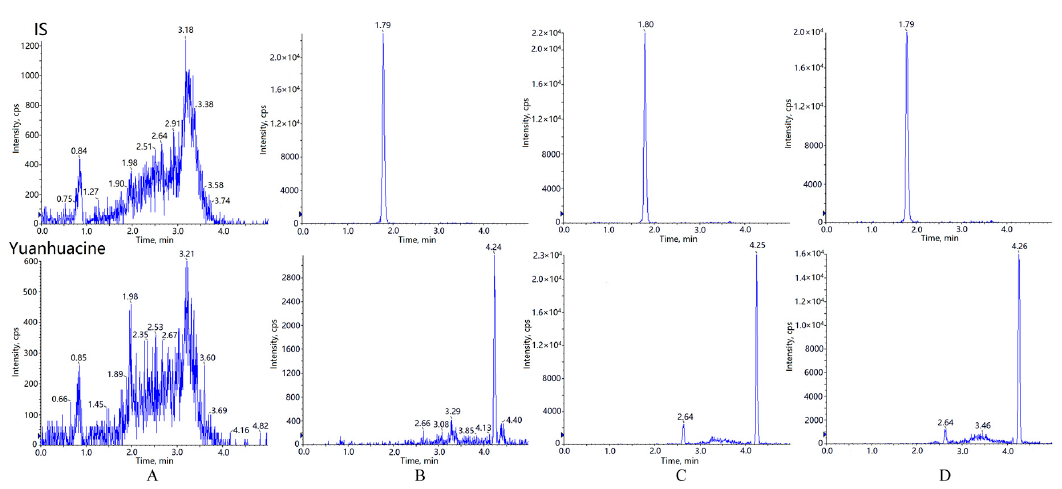
Figure 1. Representative MRM chromatograms for yuanhuacine and IS detection in plasma: ( A ) blank plasma; ( B ) blank plasma spiked with standard solutions in LLOQ; ( C ) plasma sample obtained 0.5 h after intravenous administration of yuanhuacine; ( D ) plasma sample obtained 0.5 h after pulmonary administration of yuanhuacine.